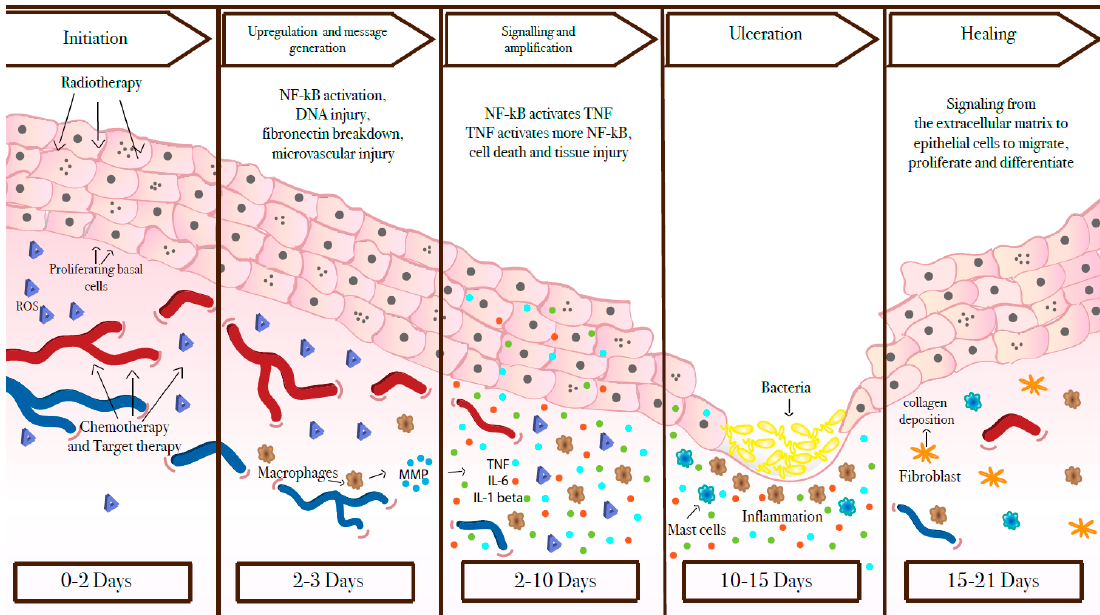
Figure 1. Mucositis pathobiology. This model has proven relevant for oral mucositis and gastrointestinal mucositis induced by chemotherapy and radiotherapy [7,13]. Conversely, there is still little information about the pathogenesis of mucositis associated with the newer anticancer treatment, but they likely di ff er from “classical